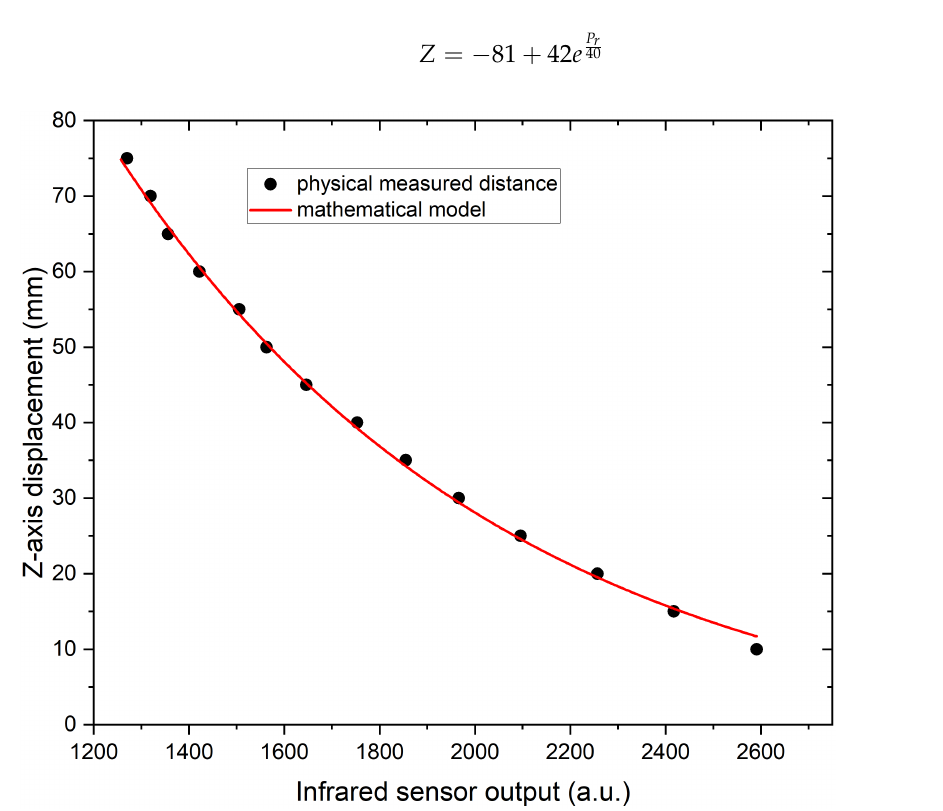
Figure 7. The relationship between the Z-axis displacement and the infrared sensor data: symbols represent the measured physical distances, and the solid line the mathematical model of the Z-axis displacement.